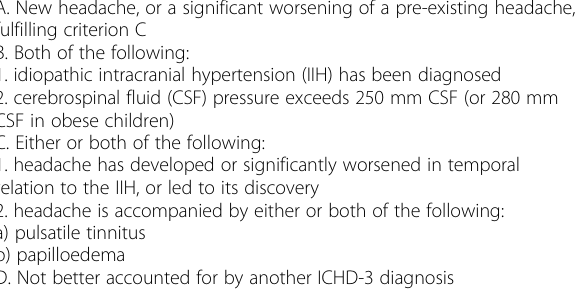
Table 1 Diagnostic criteria for IIH-related headache according to the International Classification of Headache Disorders